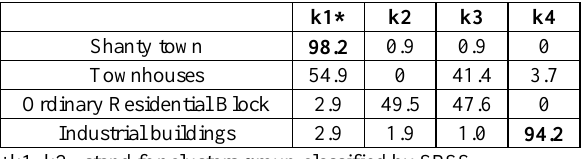
Table 2. Final cluster centers of k-means